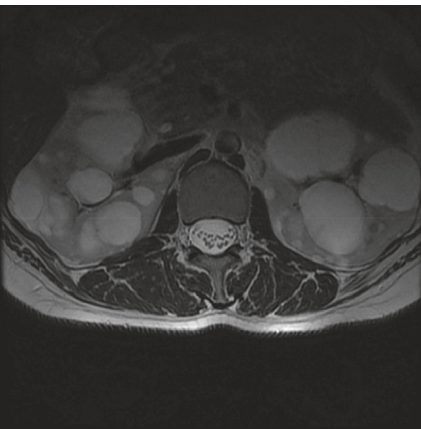
Figure 6: T2-weighted axial MRI scan showing polycystic